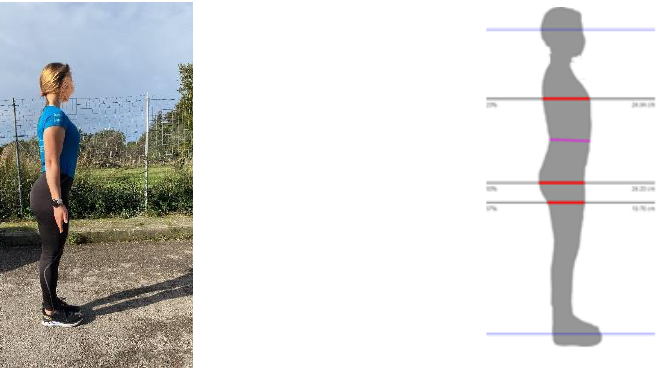
Figure 2. Images showing the sequence of digital image acquisition and software-determined landmarks for estimation of body fat. Digital photograph of lateral side of an individual in an unrestricted environment. Uploaded digital image of lateral surface of the individual with software-derived silhouette showing horizontal transverse lines designated with machine learning that identify the chest, belly, thigh, and calf sites.